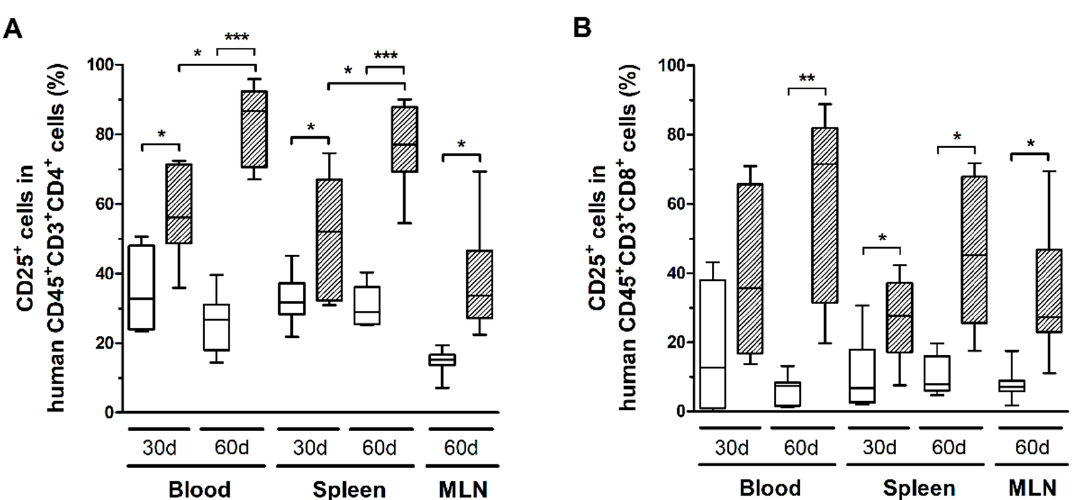
Figure 5. CD25 expression in T-cell subsets. Blood, spleen, and mesenteric lymph nodes (MLN) from control (white box) and HTLV-1-infected HIS-NSG mice (dashed box) were sampled at 30 days and 60 days from inoculation. CD25 expression in ( A ) CD4 + and ( B ) CD8 + human T-cells (CD45 + CD3 + cells) was determined by flow cytometry. Statistical analysis was performed with Student’s t -test (*, p < 0.05; **, p < 0.01; ***, p < 0.001). Control groups 30 d and 60 d: n = 7; HTLV-1-infected group 30 d: n = 8; HTLV-1-infected group 60 d: n = 6.